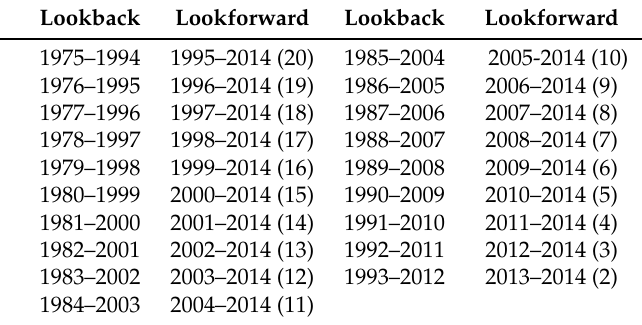
Table 3. Rolling fixed-length horizon backtests data horizon.